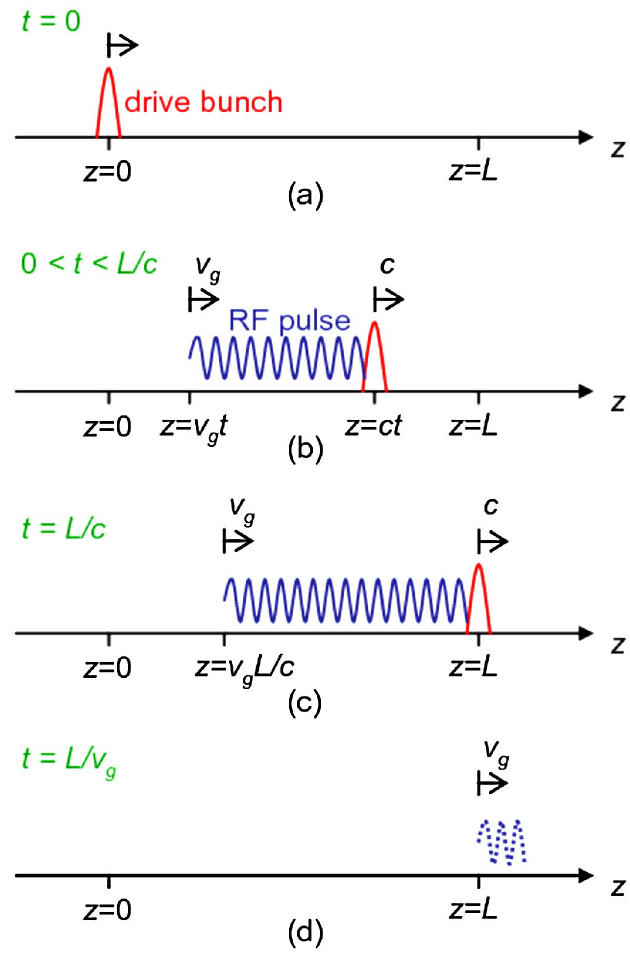
FIG. 3. (Color) The rf pulse due to a single drive bunch. Snapshots of a single bunch and the excited rf pulse inside the decelerator region 0 (cid:2) z (cid:2) L . (a) The bunch enters the decel- erator ( t (cid:3) 0 ); (b) the bunch and the rf pulse are fully inside the decelerator where the head and the tail of the rf pulse travel at different speed ( 0 < t < L=c ); (c) the bunch reaches the exit of the decelerator ( t (cid:3) L=c ); (d) the tail of the rf pulse exits the decelerator ( t (cid:3) L=v g